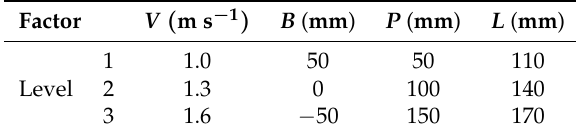
Table 2. Orthogonal factor level table of working condition